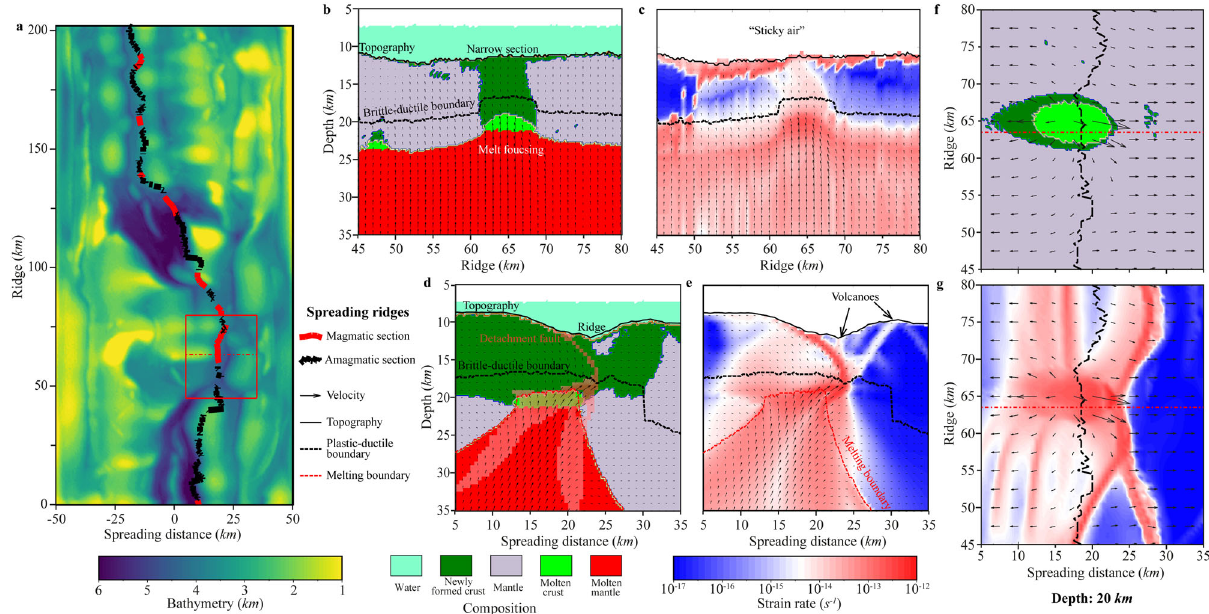
Fig. 3 Numerical modeling of ultraslow spreading ridges at an evolution time of 10.4 Myr. a Bathymetry. The red rectangle shows the area plotted in b – g . The dashed red line in the red square shows the pro fi le location (ridge = 63.5 km) in d and e . The thick dashed red and black lines show the magmatic and amagmatic sections along the spreading ridge, respectively. b , c Pro fi les of the compositions and second invariant of the strain rate tensor along spreading ridges. d , f . Pro fi les of the compositions and second invariant of the strain rate tensor along the dashed red line contained in the rectangle. The high strain localization of the hanging wall in e may provide the channel for melt migration and consequently form volcanoes at the sea fl oor. f , g Horizontal slices showing the compositions and second invariant of the strain rate tensor at a depth of 20 km. The dashed black lines show the locations of spreading ridges. The very thick crust is likely due to the overfocusing of crustal growth that is introduced by the current simpli fi ed melt extraction and transport algorithm (see discussion in